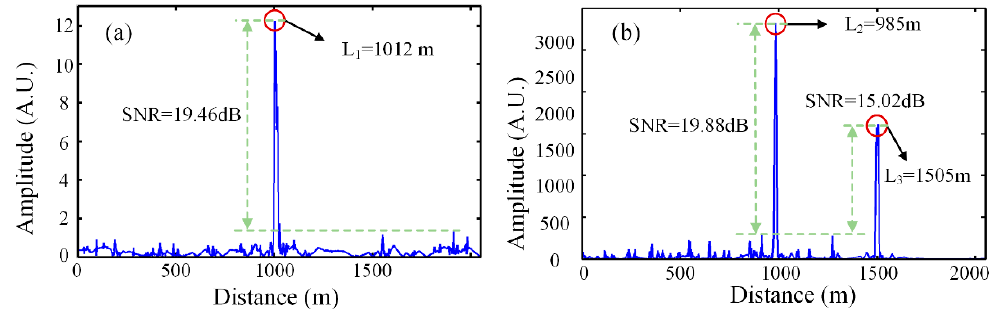
Figure 8. Position curves after differential accumulation algorithm for ( a ) the single-point vibration position and ( b ) the multi-point vibration positions.